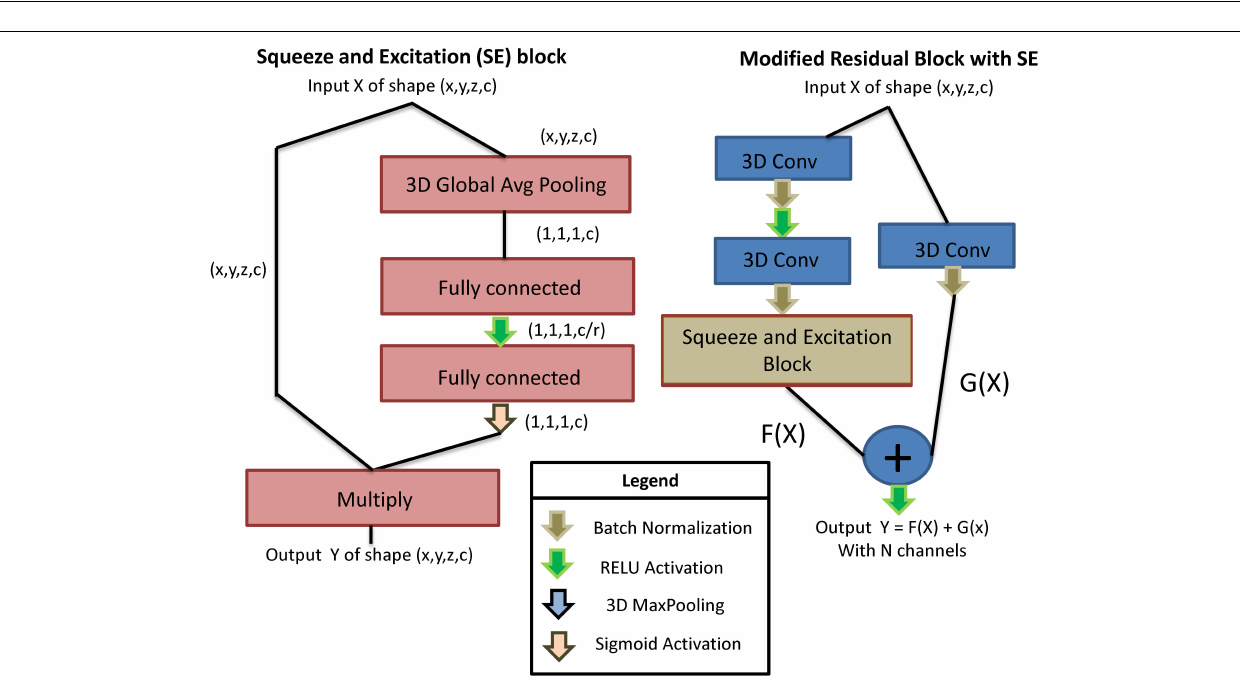
FIGURE 2 | Left: The building blocks of an SE block. Right: A modified residual block with SE. The double convolutional path of the residual block is equipped with a SE block that captures attention weights for different channels of the convolutional kernels.